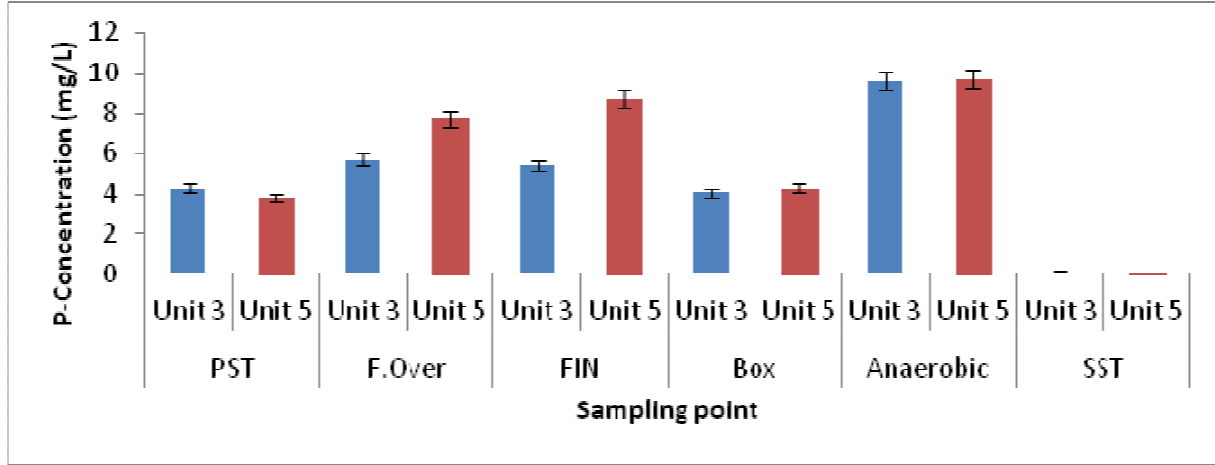
Figure 2. Orthophosphate concentration in wastewater samples collected from different zones of both Unit-3 and Unit-5 of the Northern Wastewater Treatment Works (PST: primary settling tanks; F.Over: overflow elutriation tanks; FIN: inside elutriation tanks; SST: secondary settling